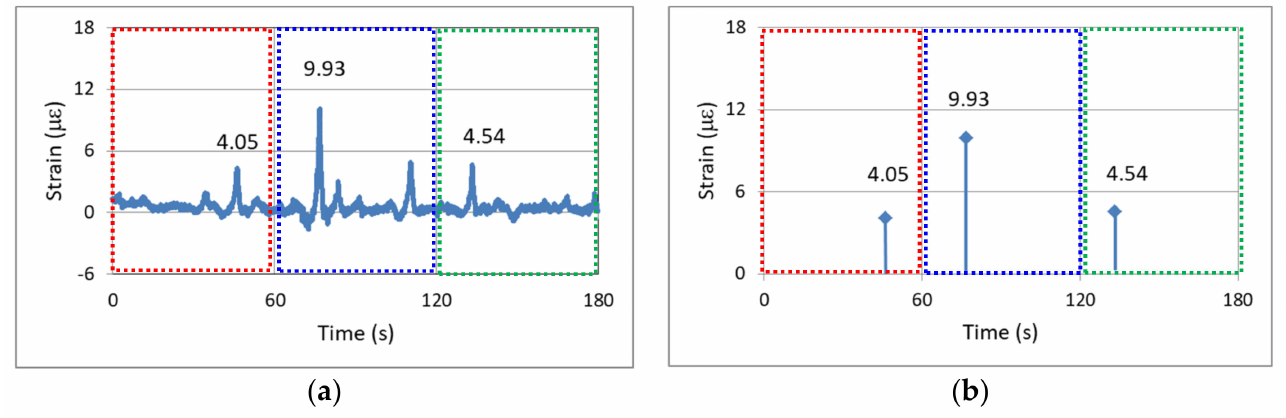
Figure 11. Dynamic strain of the investigated bridge: ( a ) continuous data output; ( b ) outputting of a maximum value every